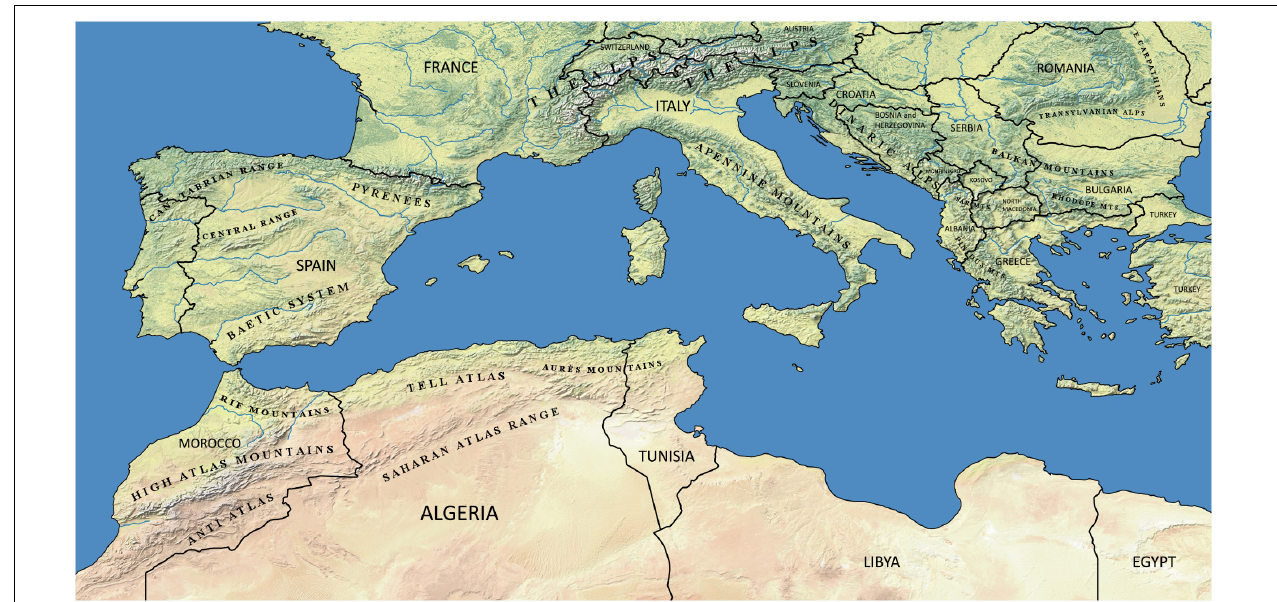
FIGURE 4 | Main mountain ranges of North Africa, East and South Europe (original source: Natural Earth raster + vector